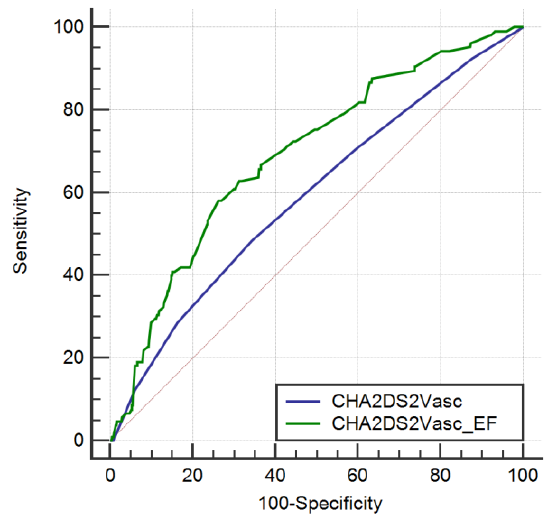
Figure 2. Comparison of ROC curves between the CHA2DS2-Vasc model and CHA2DS2-Vasc + LVEF model. The red line denotes the area of 0.5 of a random classifier.